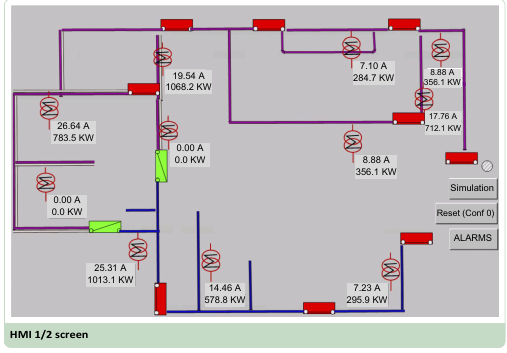
Figure 3. Initial accuracy heat